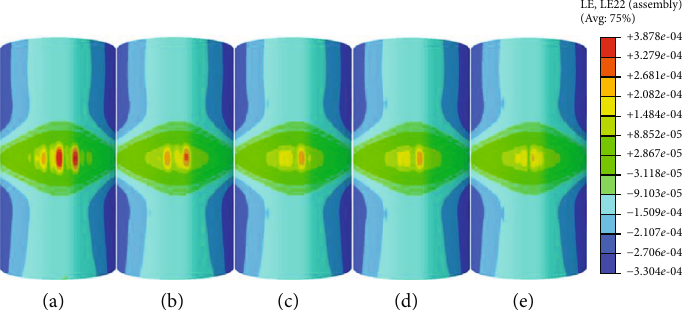
Figure 7: Strain maps of outer concrete core at the springline under combined loads: (a) P-t-0; (b) P-t-2; (c) P-t-4; (d) P-t-6; (e) P-t-8.